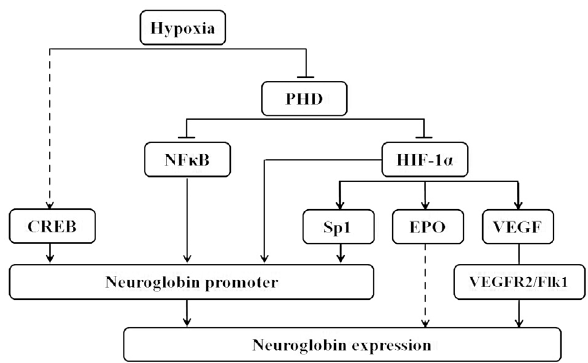
Figure 1 Possible mechanisms for Ngb up-regulation in response to